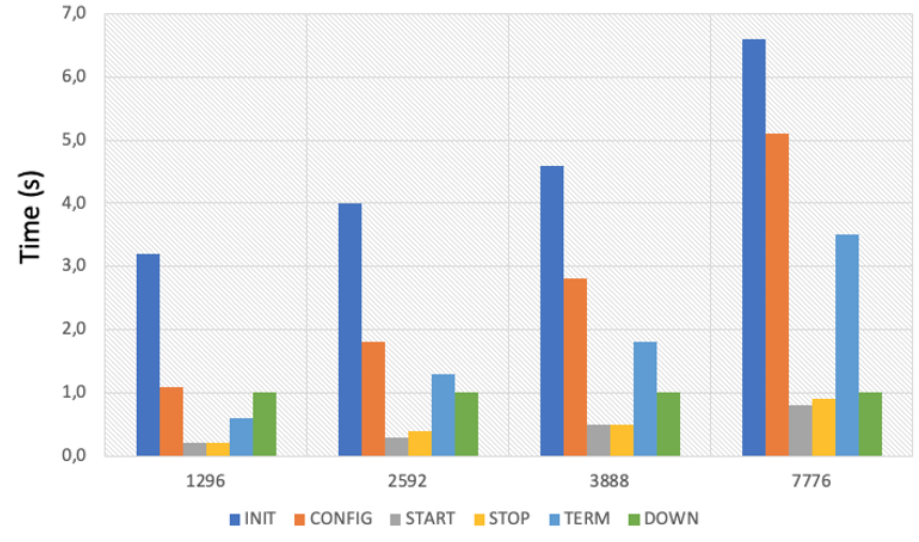
Figure 2. Time in seconds to execute the actions with the number of